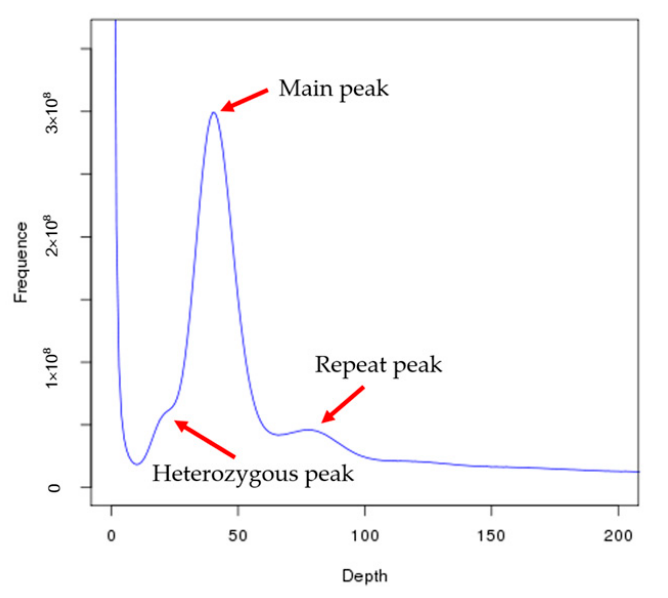
Figure 2. 17 K-mer analysis for estimating the genome size of C. roscoffensis. The distribution of 17-mer was calculated using jellyfish (version2.1.3) based on the sequencing data from short insert size libraries and the genome size was estimated based on the formula: genome size = total_kmer_num / kmer_depth, where total_kmer_num is the total number of K-mer and kmer_depth indicates the peak position on the K-mer frequency distribution map. Heterozygous peak indicates the genome heterozygosity, repeat peak represents the repeat rate of the genome. Table 1. Survey statistic results of C. roscoffensis